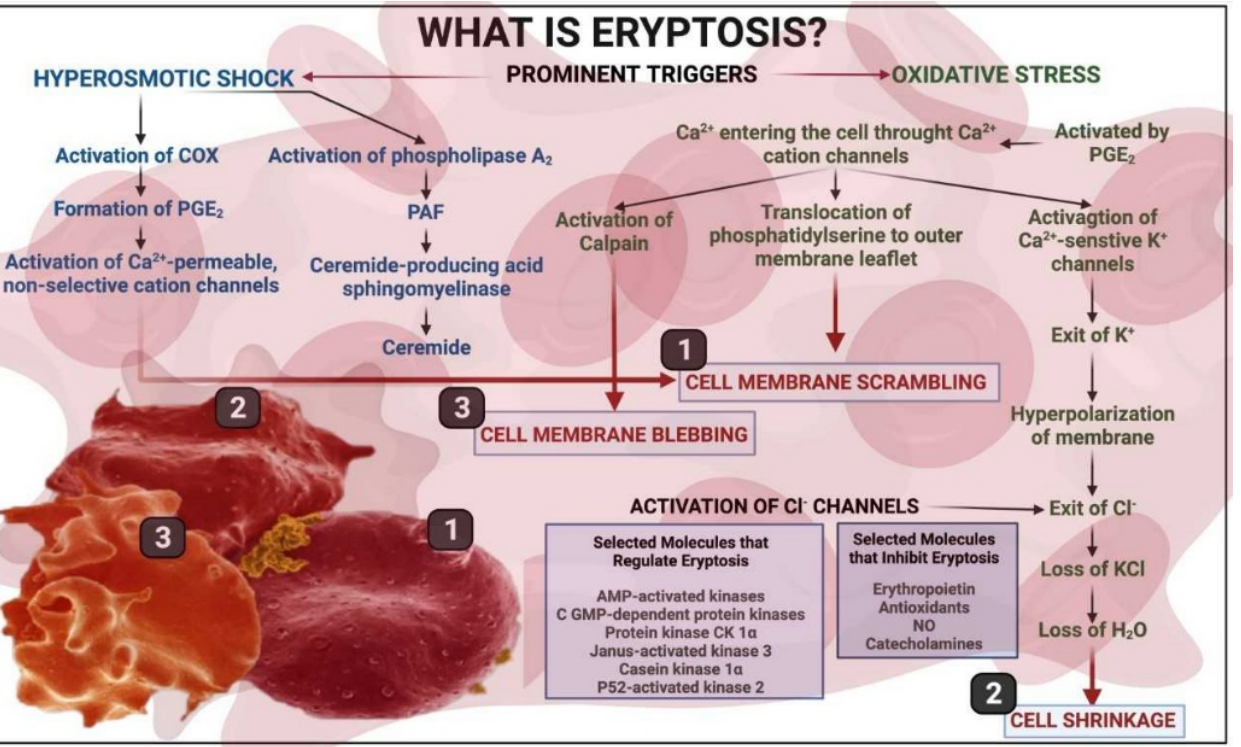
Figure 1. A brief overview of eryptosis (adapted from [47]) showing the pathways that initiate it, under the influence of osmotic shock or oxidative stress, resulting in activation of intracellular path- ways, leading in turn to phospholipid membrane scrambling (1); cell shrinkage (2); and membrane blebbing (3). Figure created using www.biorender.com accessed on 17 December